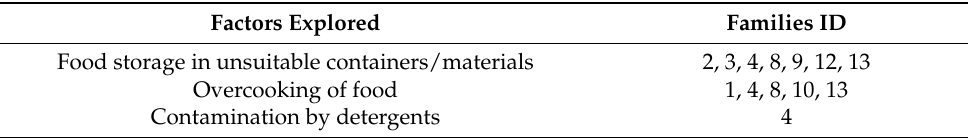
Table 4. Factors that facilitate chemical risks in the